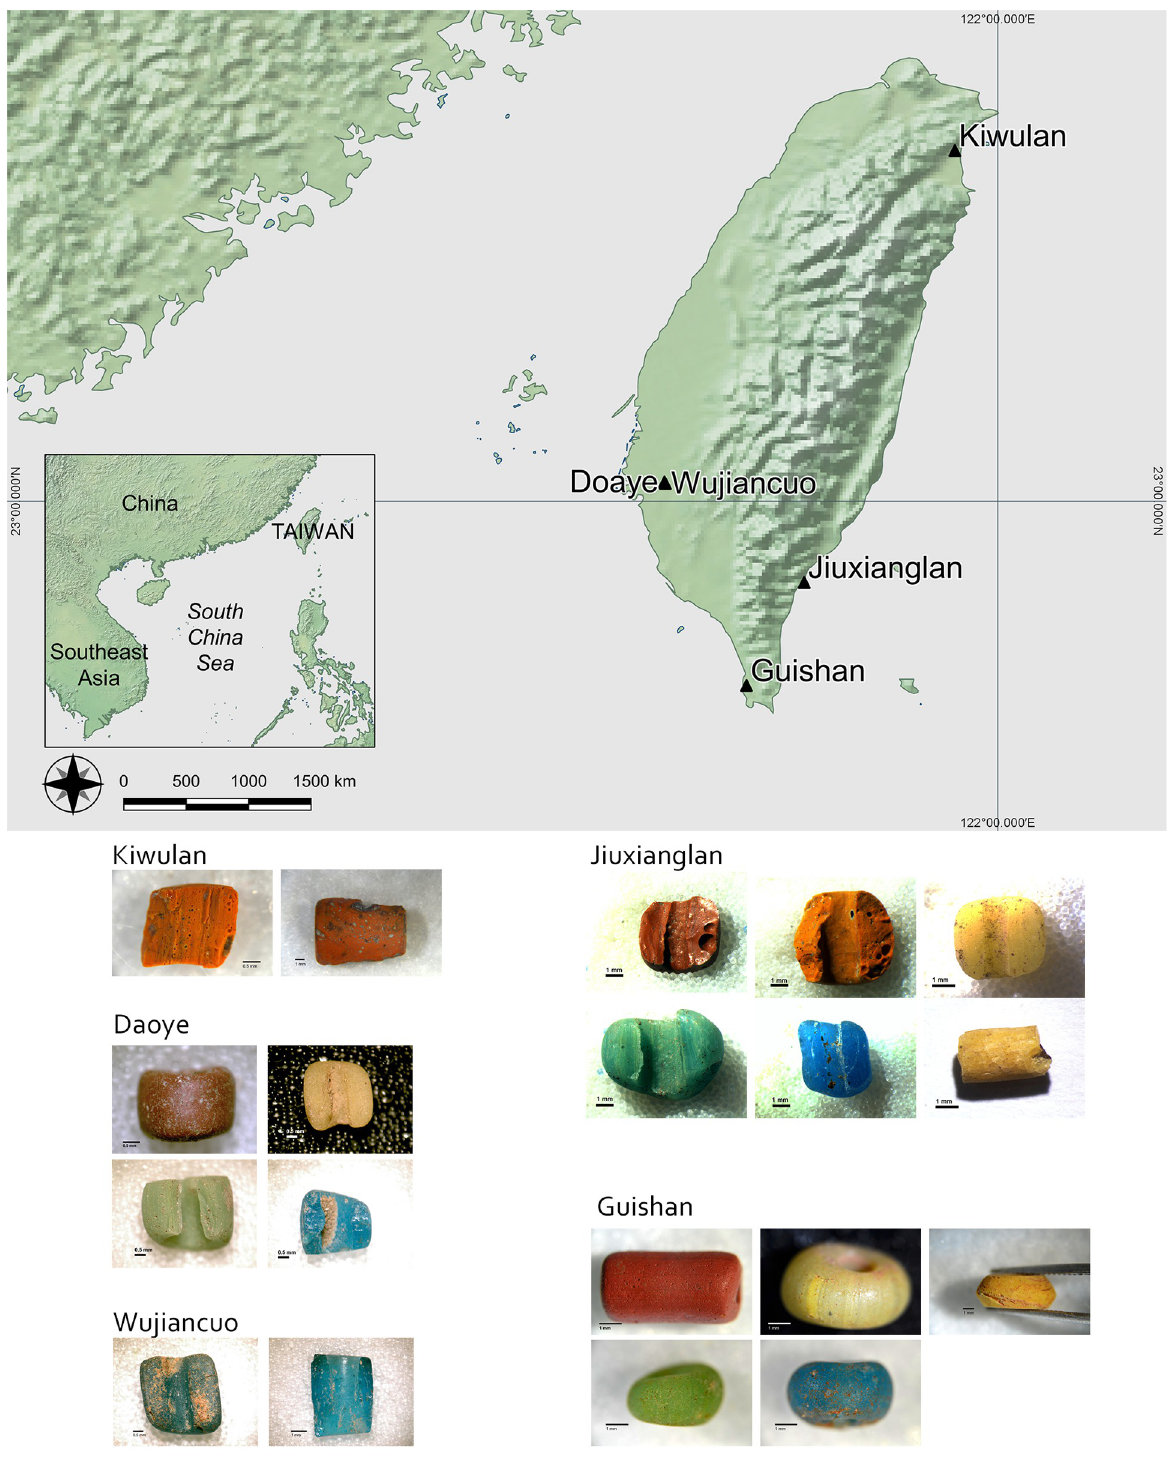
Fig 1. Map showing the location of study sites (above), and bead samples from each site (below). (Map made with Natural Earth. Free vector and raster map data @ naturalearthdata.com.).